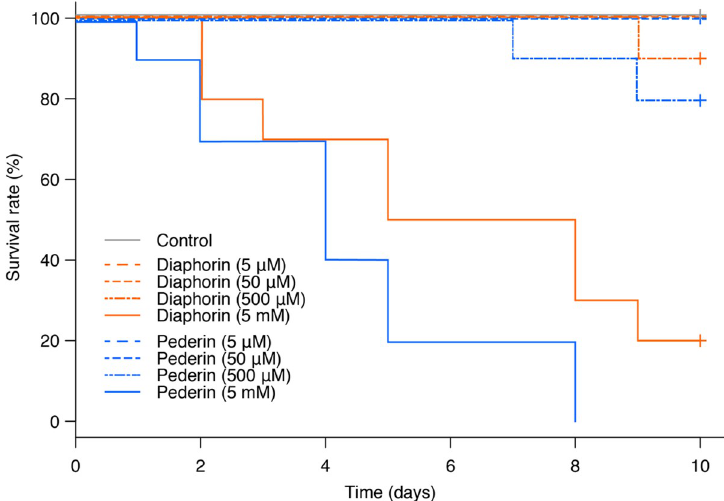
Fig 4. Survival rates of lady beetles treated with diaphorin or pederin. Kaplan–Meier survival curves of H . axyridis treated with 5 μ M–5 mM diaphorin or pederin (diaphorin: orange; pederin: blue; control: grey). Data derived from two independent experiments (total of 10 cases per treatment) were pooled and plotted on a single graph. Vertical tick marks indicate the censored times. The log-rank test and the Holm–Sidak test detected significant differences between the control and 5 mM diaphorin treatment ( p = 0.01315) and between the control and 5 mM pederin treatment ( p = 0.00029).